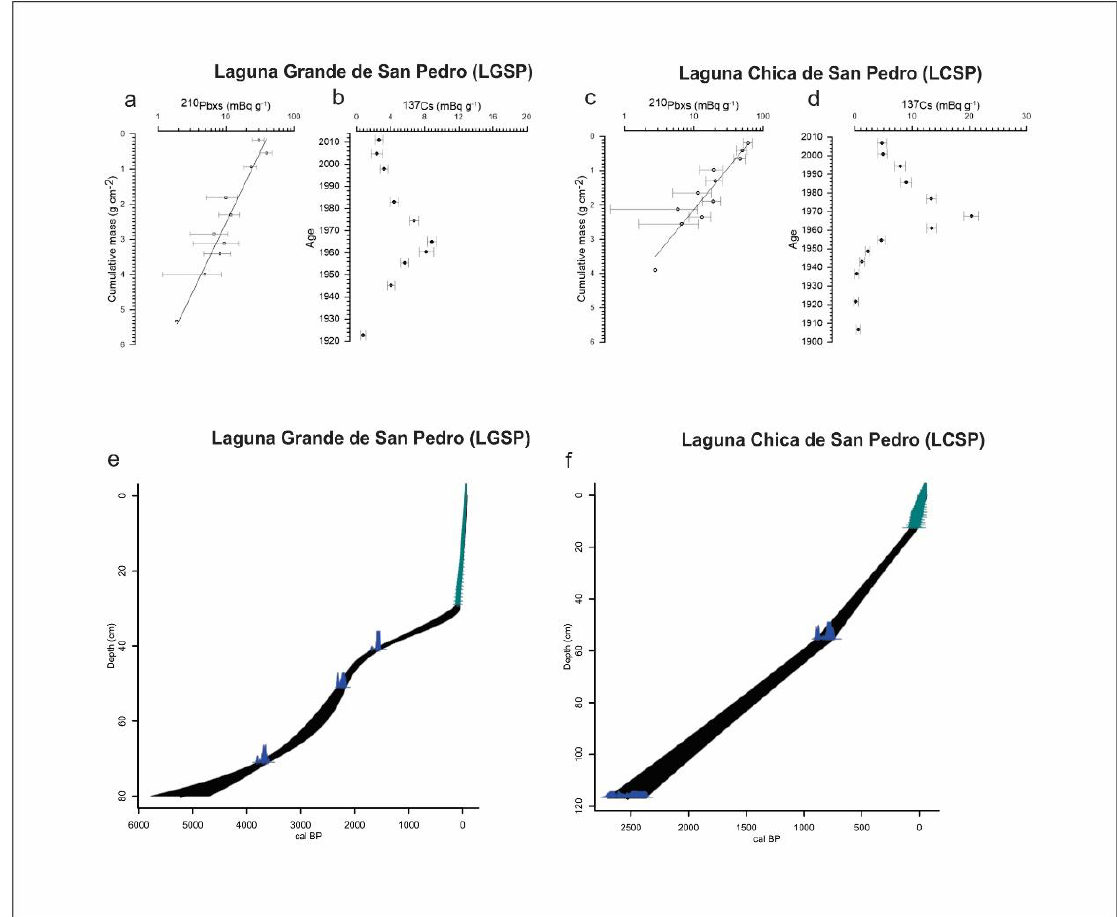
Figure 2. Chronology of the top centimetres of the Laguna Grande ( a , b , e ) and Laguna Chica ( c , d , f ) de San Pedro. The dark line represents the age model, while the grey shades represent the estimated errors, and the vertical and grey lines indicate the coring year.